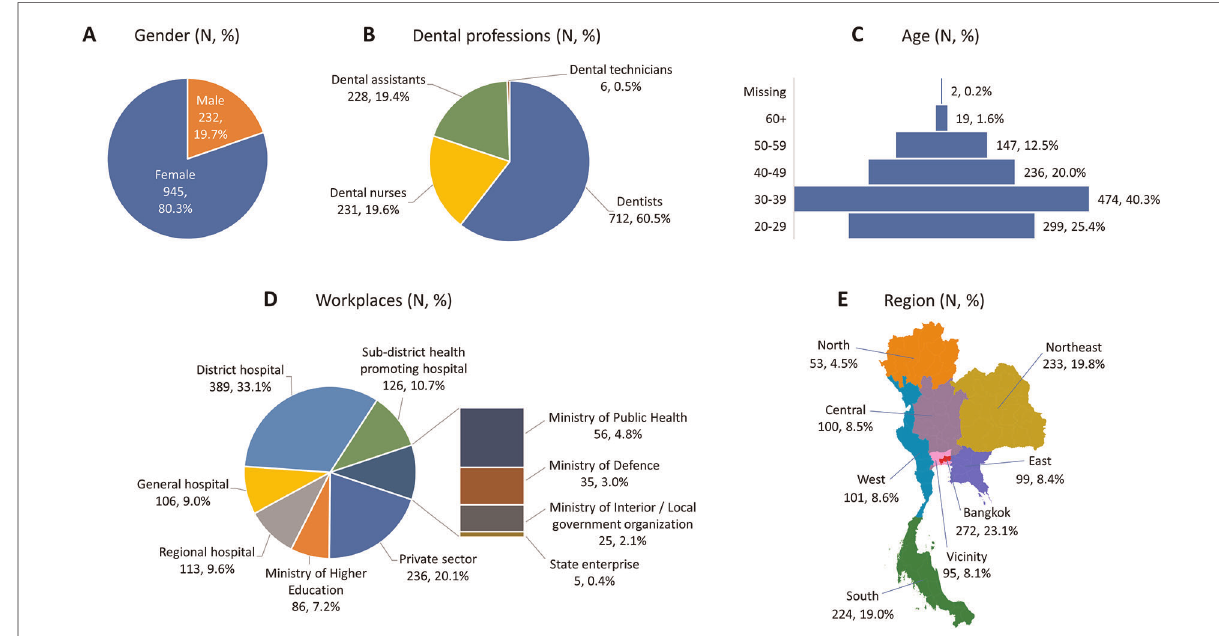
FIGURE 1 Respondent demographics classi fi ed by ( A ) sex, ( B ) dental personnel level, ( C ) age pro fi le, ( D ) workplace, and ( E ) region ( N ,